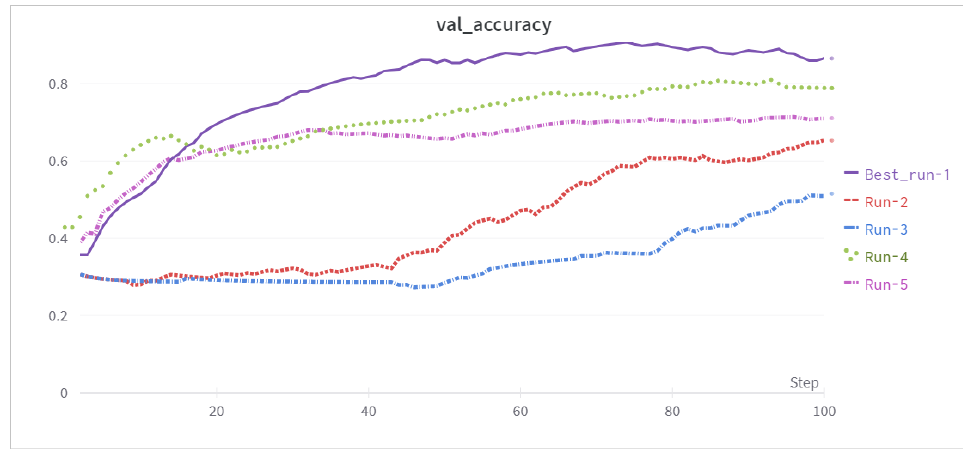
Figure 4. Evaluation accuracies for our Split Model with train–test split for multiple